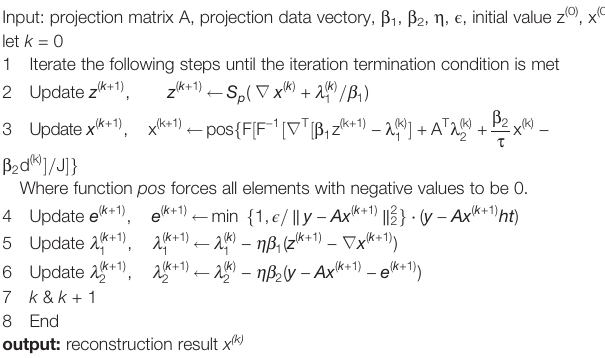
TABLE 2 | TpV minimization algorithm